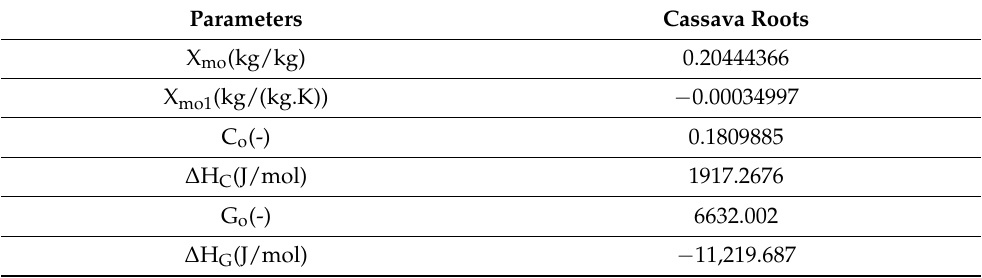
Table 2. Parameters desorption isotherms model of the GAB model obtained using data taken from Ajala et al.